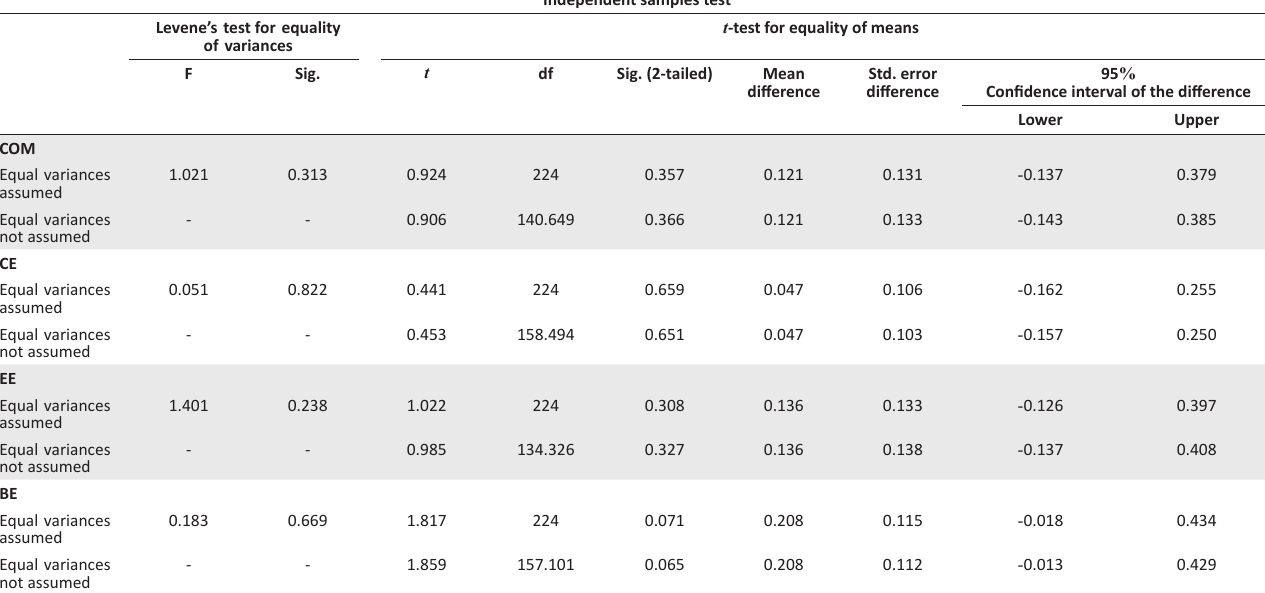
TABLE 4b: Independent t -test analysis.